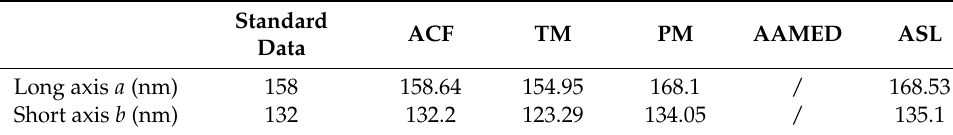
Table 2. Standard data and the results of the compared methods on dataset 2. Standard